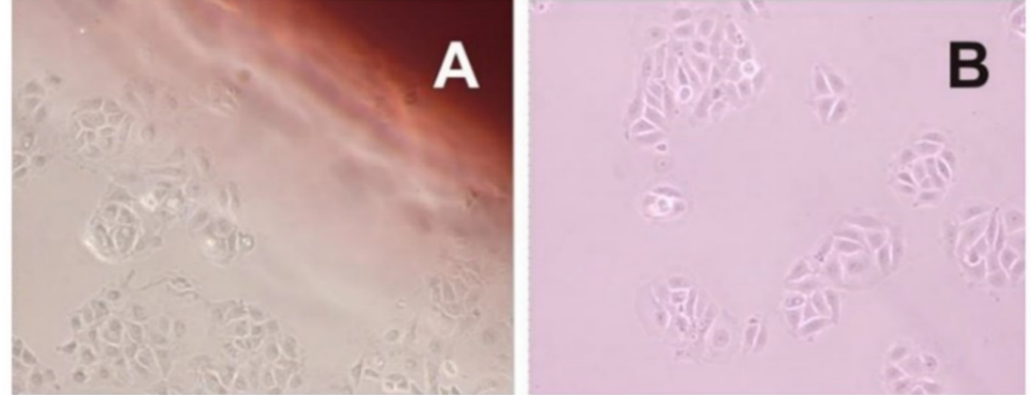
Figure 10. Morphology of MCF-7 cells after 24 h in the presence of P-film (Panel A ) and A-film (Panel B